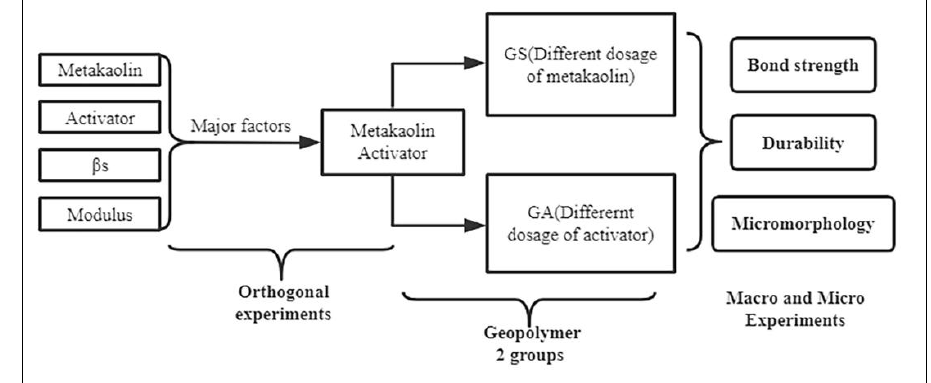
Figure 1. Experimental flow chart.